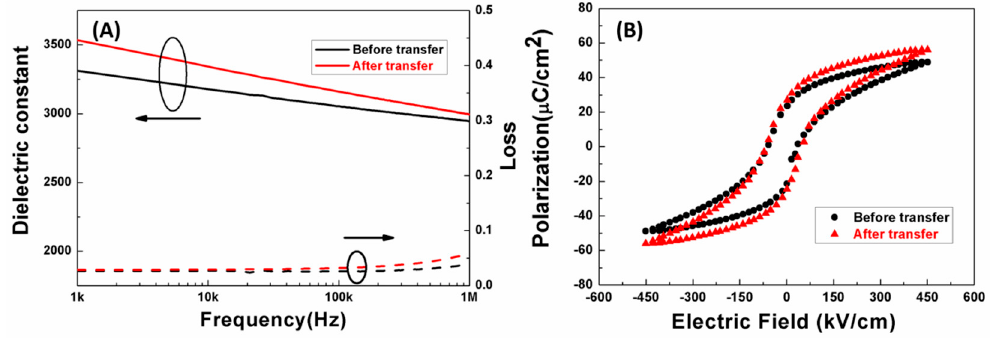
Figure 4. ( A ) Frequency dependent dielectric properties and ( B ) ferroelectric properties of the PMN-PT thick film before and after transfer.